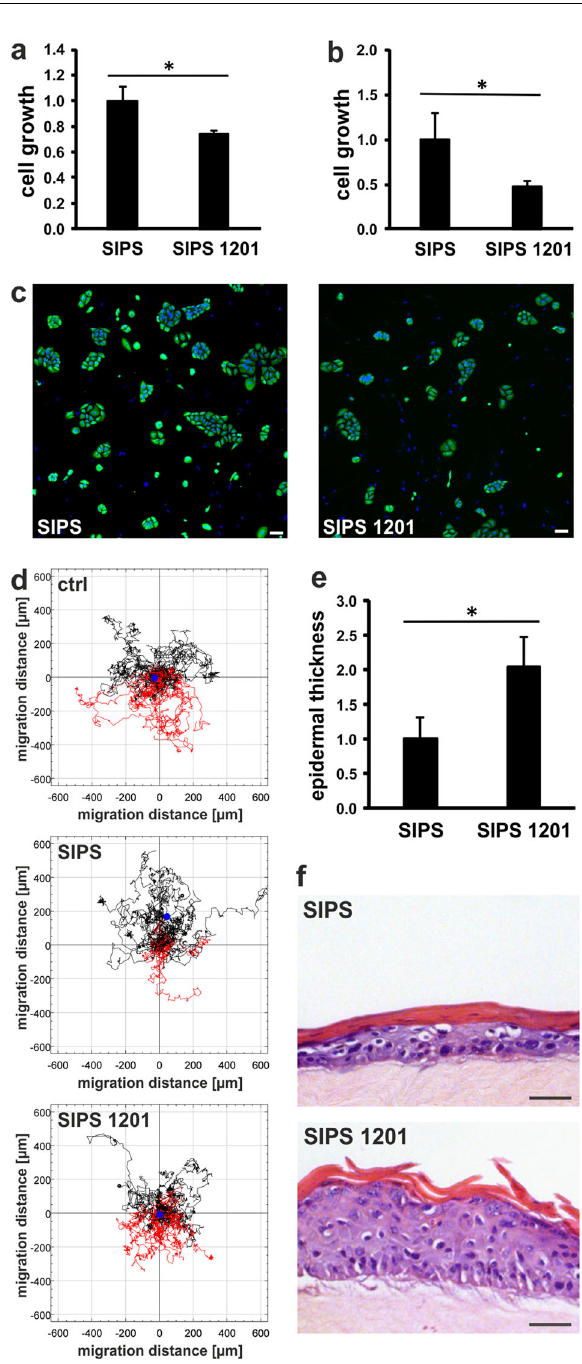
Fig. 6 1201 blocks the effects of SIPS HDFs on other cells. SASP- attenuating properties of 1201 were evaluated by pre-treatment of SIPS HDFs with 1201 for 4 days and analysing the growth stimulation of HaCaT cells by either a counting K14-positive cells after co-culture with SIPS HDFs or b determining the cell number after cultivation with conditioned medium. c Representative pictures from one experiment as described in a . Scale bar, 100 µm. d Migration assay using SIPS HDF-derived conditioned medium and human PBMCs. Migratory paths are coloured in black if cells are migrating upwards, in the direction of the conditioned medium. The blue dot marks the centre of mass. e Full-thickness HSEs with SIPS HDFs were constructed as described in the Methods section and the epidermal thickness of control HSEs was set to 1. f Representative pictures from one experiment as described in e . Scale bar, 50 µm. For a , b and e , data represent the average of three experiments. For d , data represent one